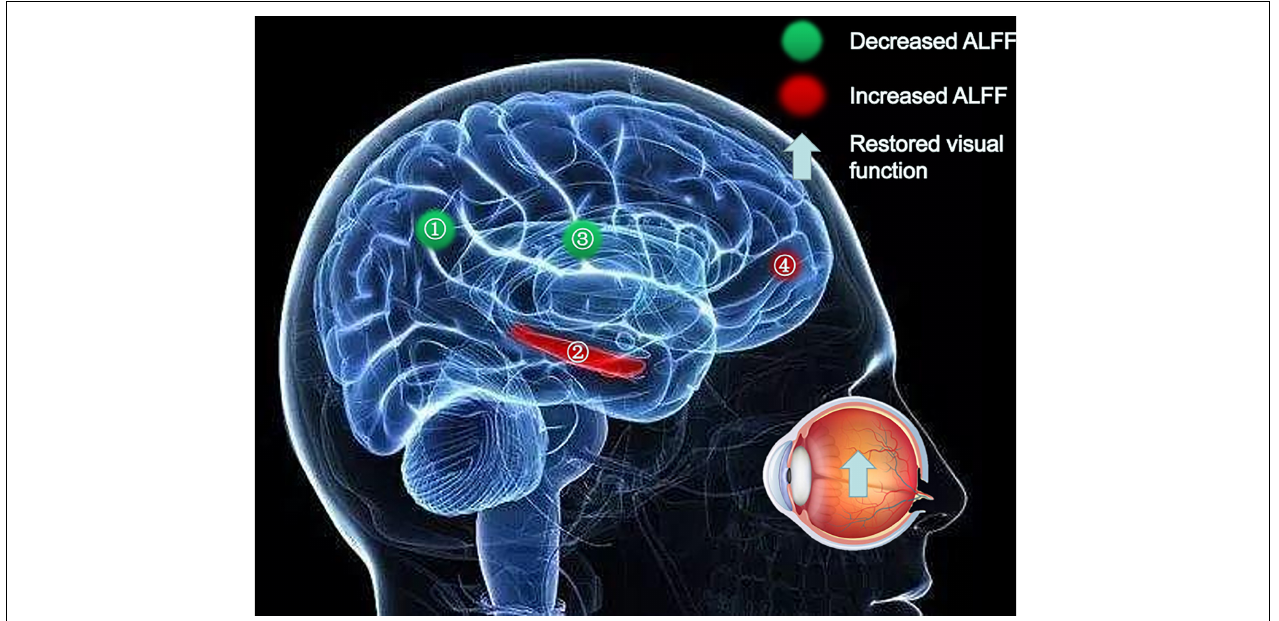
FIGURE 5 | Significant differences in spontaneous brain activity between the PRL and POL stages. Different brain regions that were observed: (1) Angular_R and Parietal_Inf_L; (2) Fusiform_R; (3) Cingulum_Mid_R; (4) Frontal_Inf_Orb_L. The red areas indicate increased ALFF values, and the green areas indicate decreased ALFF values. ALFF, amplitude of low-frequency fluctuation; L, left; R, right.